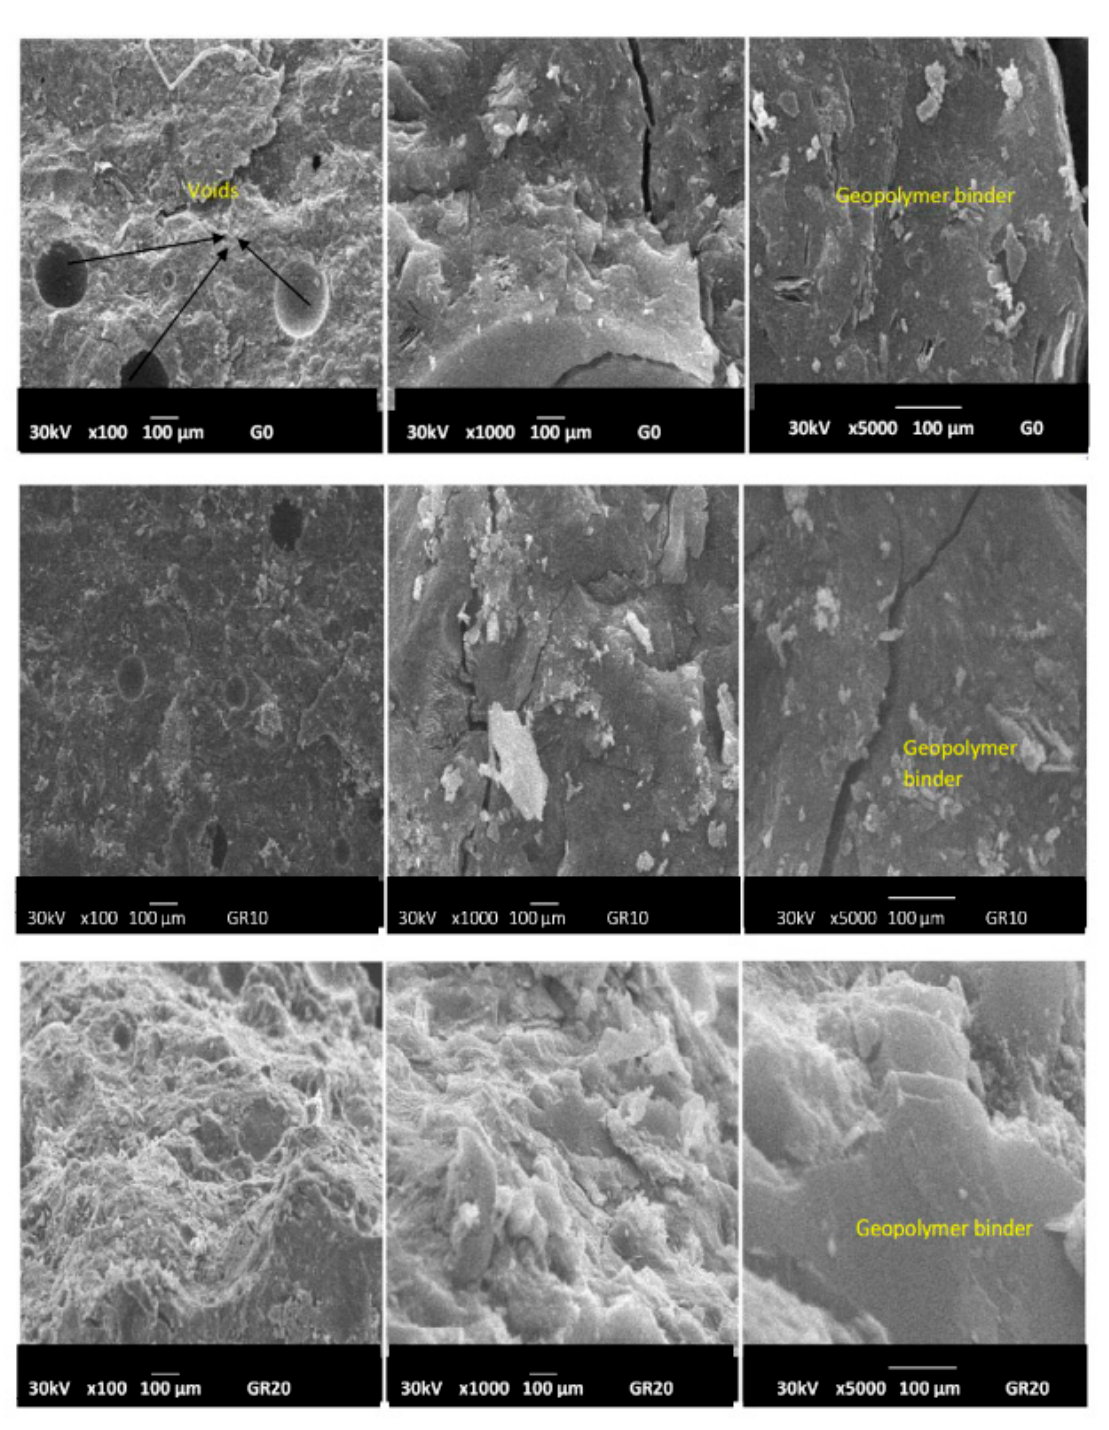
Figure 11. Micrograph images of geopolymer materials without (G0) and with the addition of hematite (GR10, GR20) with magnifications of x100, x1000, x 5000 (from left to right ).